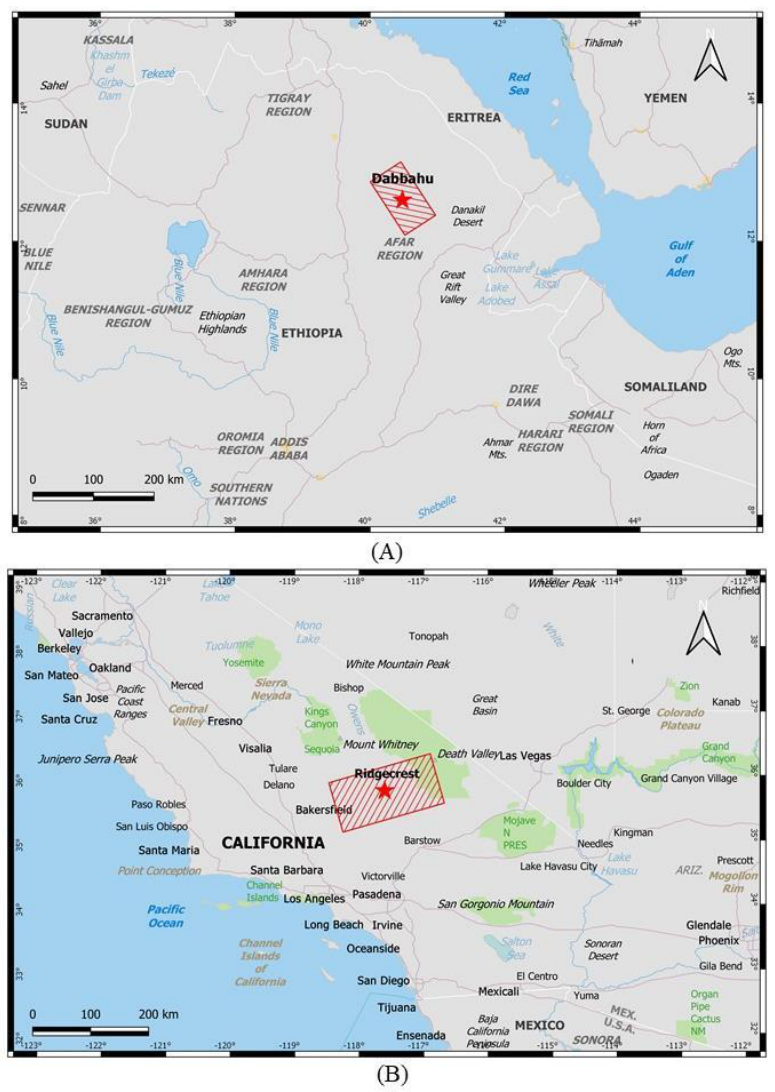
Figure 8. Geographical maps of the case study areas. (A) Afar depression, Ethiopia, and (B) Ridgecrest, California, USA. Red rectangles in (A) and (B) represent the footprints of the used ASAR/Envisat and Sentinel-1 datasets, respectively.